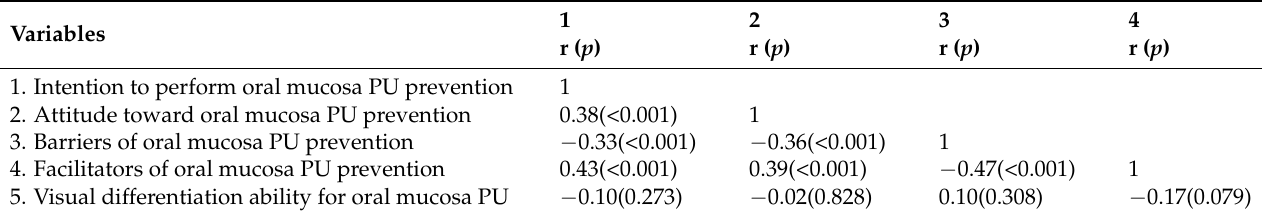
Table 4. Correlations among variables (N =